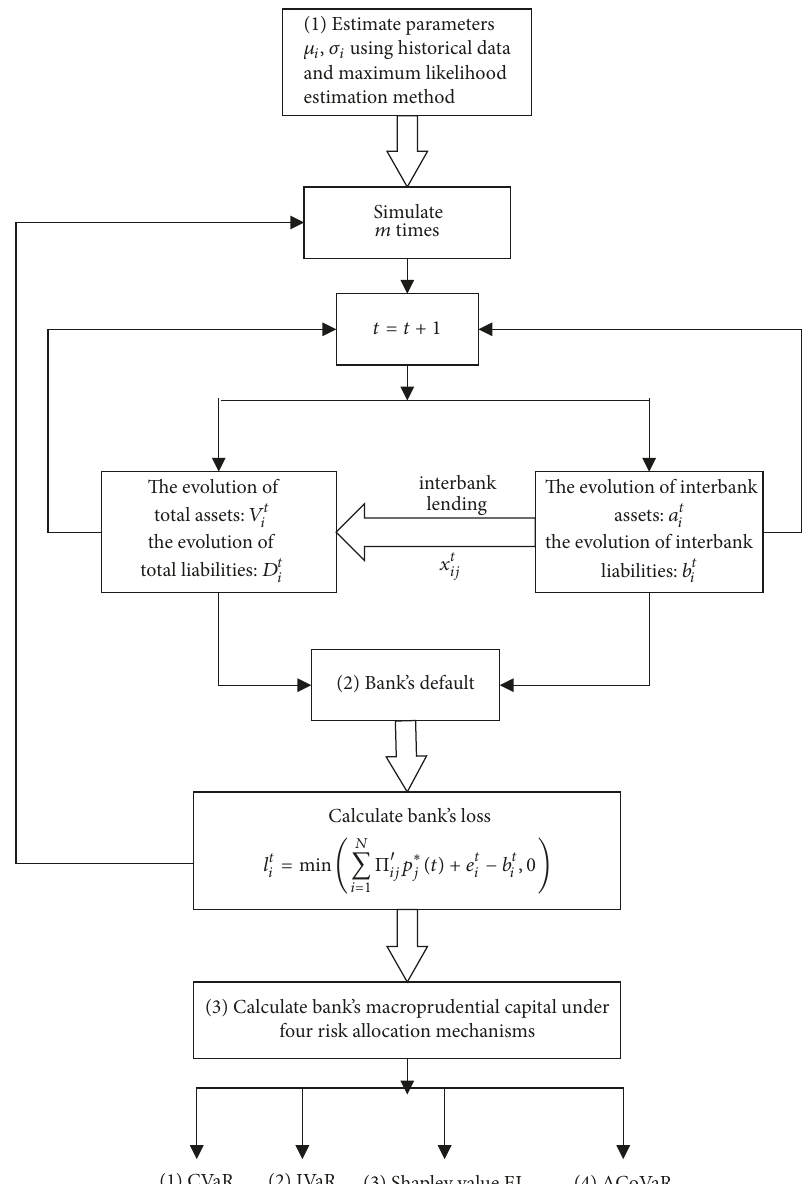
Figure 2: The algorithm flowchart of calculating macroprudential capital